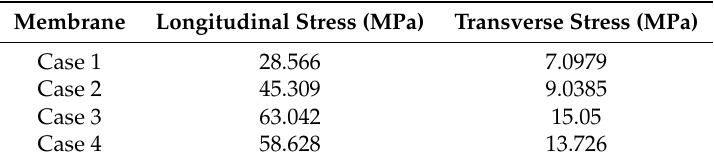
Table 2. Comparison of the maximum longitudinal stress and transverse